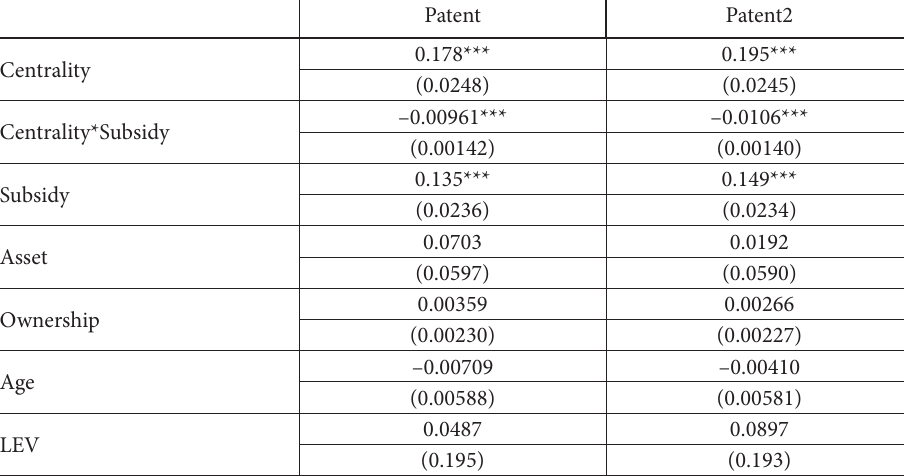
Table 6. The moderating effect of government